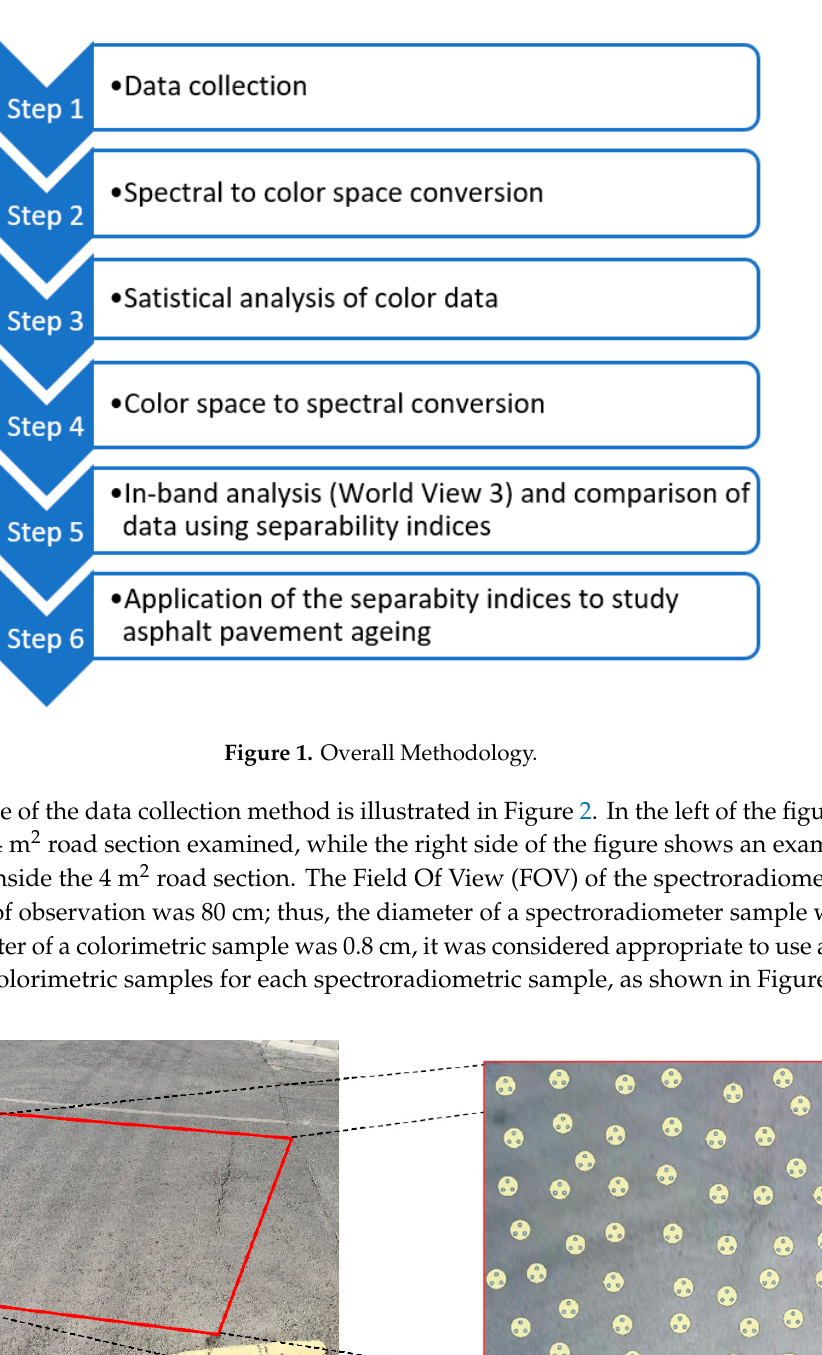
( b ) Figure 3. Spectroradiometer HR 1024 ( a ) [27] and Colorimeter WR-18 ( b ) [28].